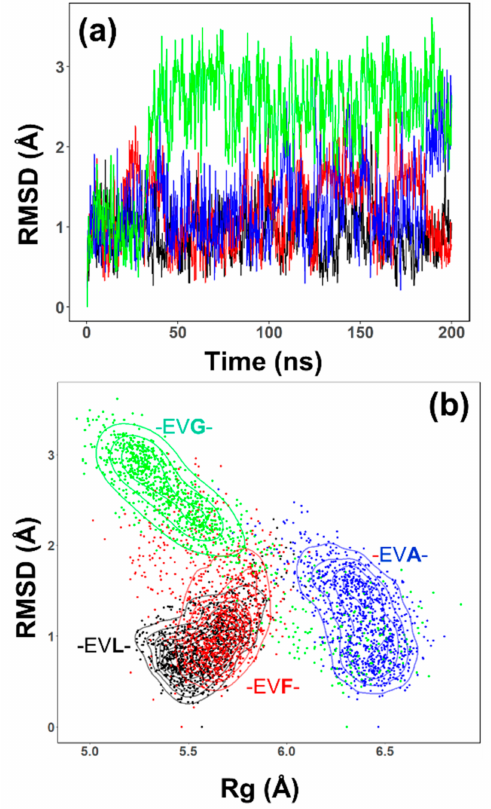
Figure 3. Summary of MD simulations. ( a ) Root-mean-squared deviation (RMSD) of the model peptides as a function of simulation time. ( b ) Correlation plot between the radius of gyration (Rg) and RMSD from the simulation results: -EVX-; X =L (black), =F (red), =A (blue) and G